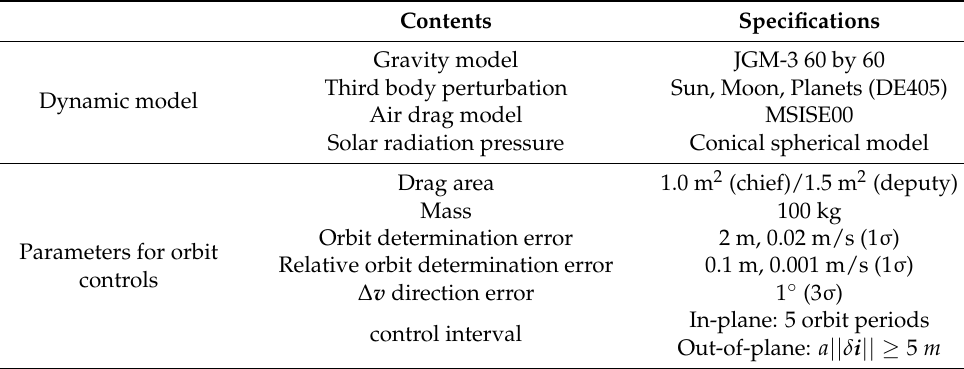
Table 4. Simulation conditions of the dynamic model and orbit control